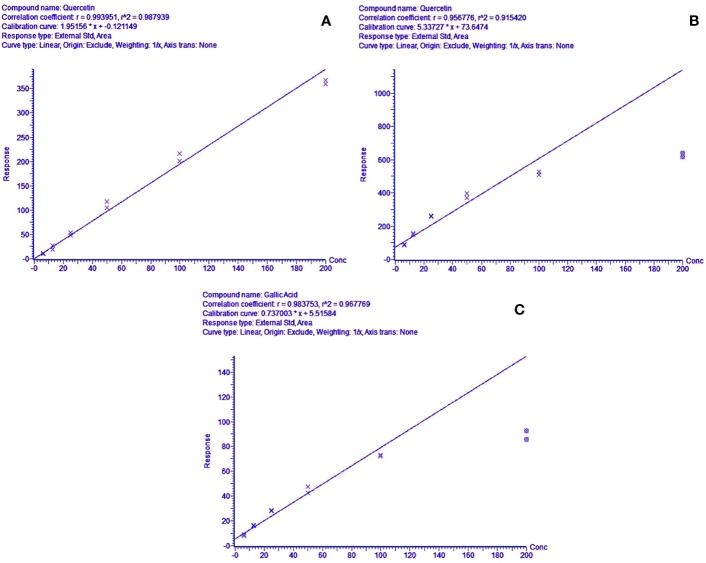
(A) Concentration range linearity for quercetin (R2 = 0.9879) in positive mode LC-MS scan, (B, C)—regression line-fit concentration range linearity for gallic acid & quercetin (R2 = 0.9441 & 0.9678) in LC-MS negative mode scans, respectively.